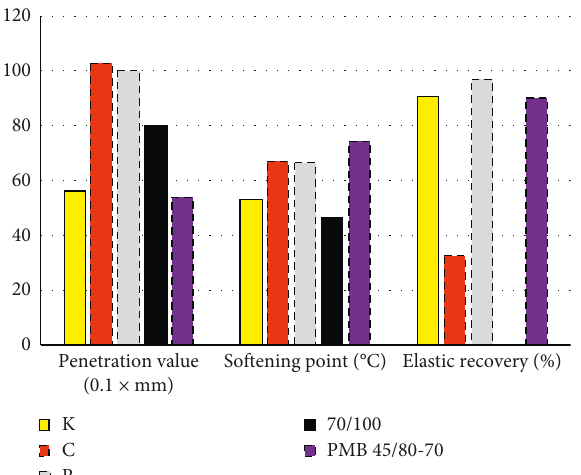
Figure 2: Penetration, softening point, and elastic recovery values of tested